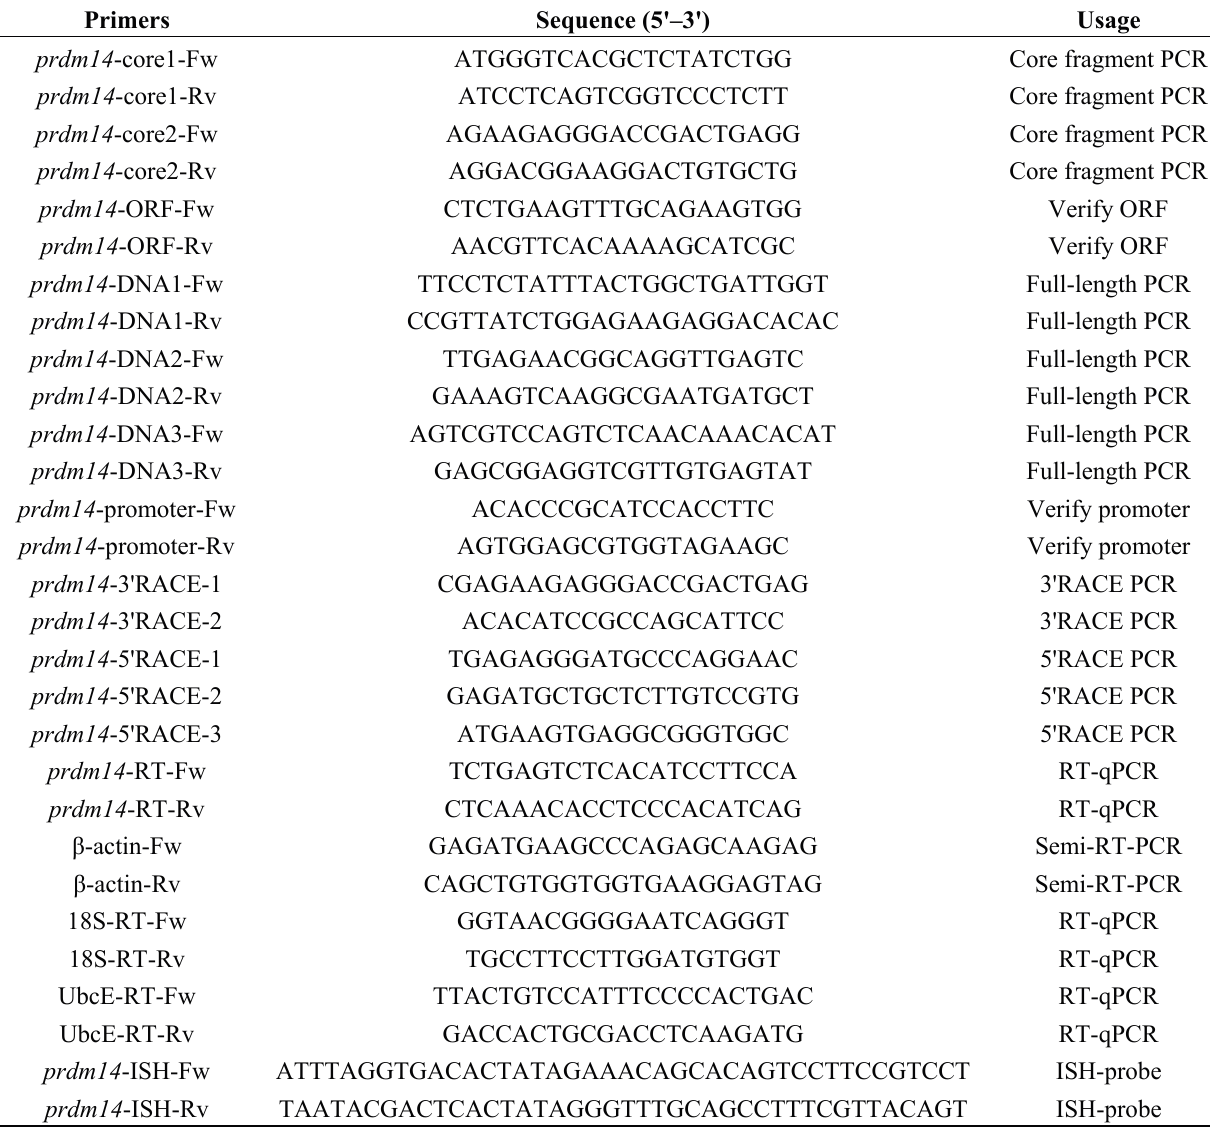
Table 1. Primers used in this